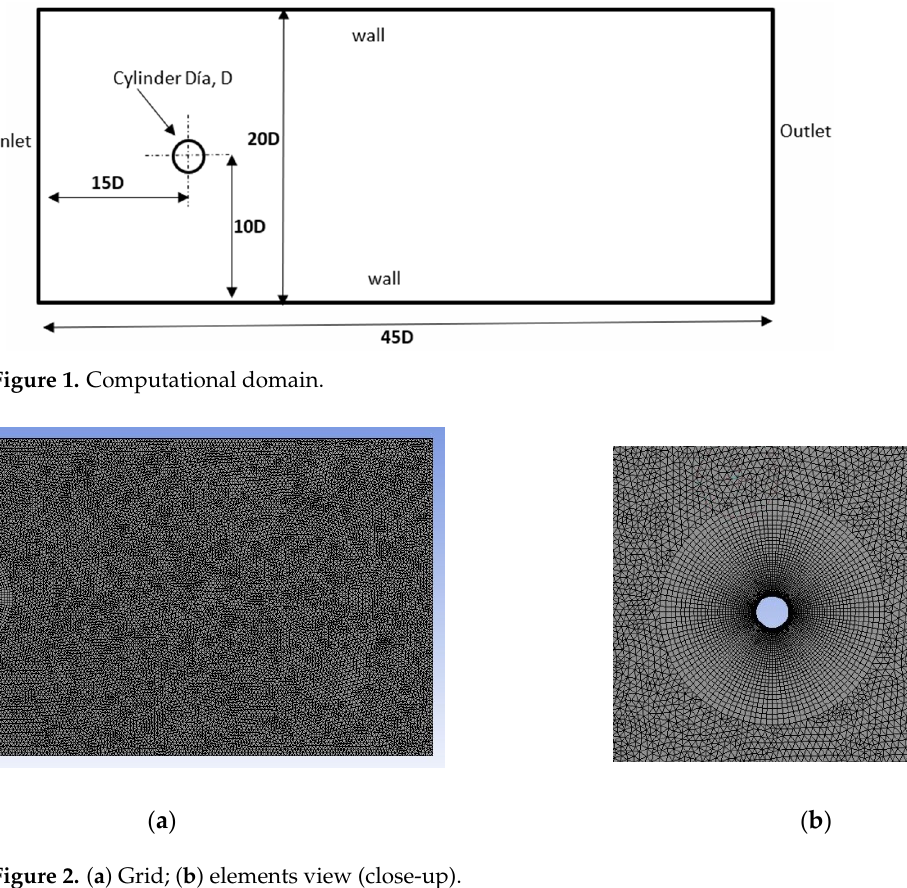
Figure 4. Schematic diagram for roughness height. 3. Results and Discussion The case studies are performed for rough cylinders with a roughness height (Ks) of 0.02 D, where D is the diameter of the cylinder, having mass ratios of 2.4 and 11. In all the cases, Re = 10,000 has been maintained with an inlet velocity of 0.3149 m/s. The simula- tions are performed within the span of reduced velocity of 2 ≤ 𝑈𝑟 ≤ 14. Figure 5 shows amplitude response in the crossflow direction at various reduced velocities for mass ratios 2.4 and 2.11 with and without surface roughness. Figure 5. Comparison of amplitude responses for a smooth cylinder and a rough cylinder (i.e., Ks/D = 2 × 10 − 2 ) with m* = 2.4 and 11. 2